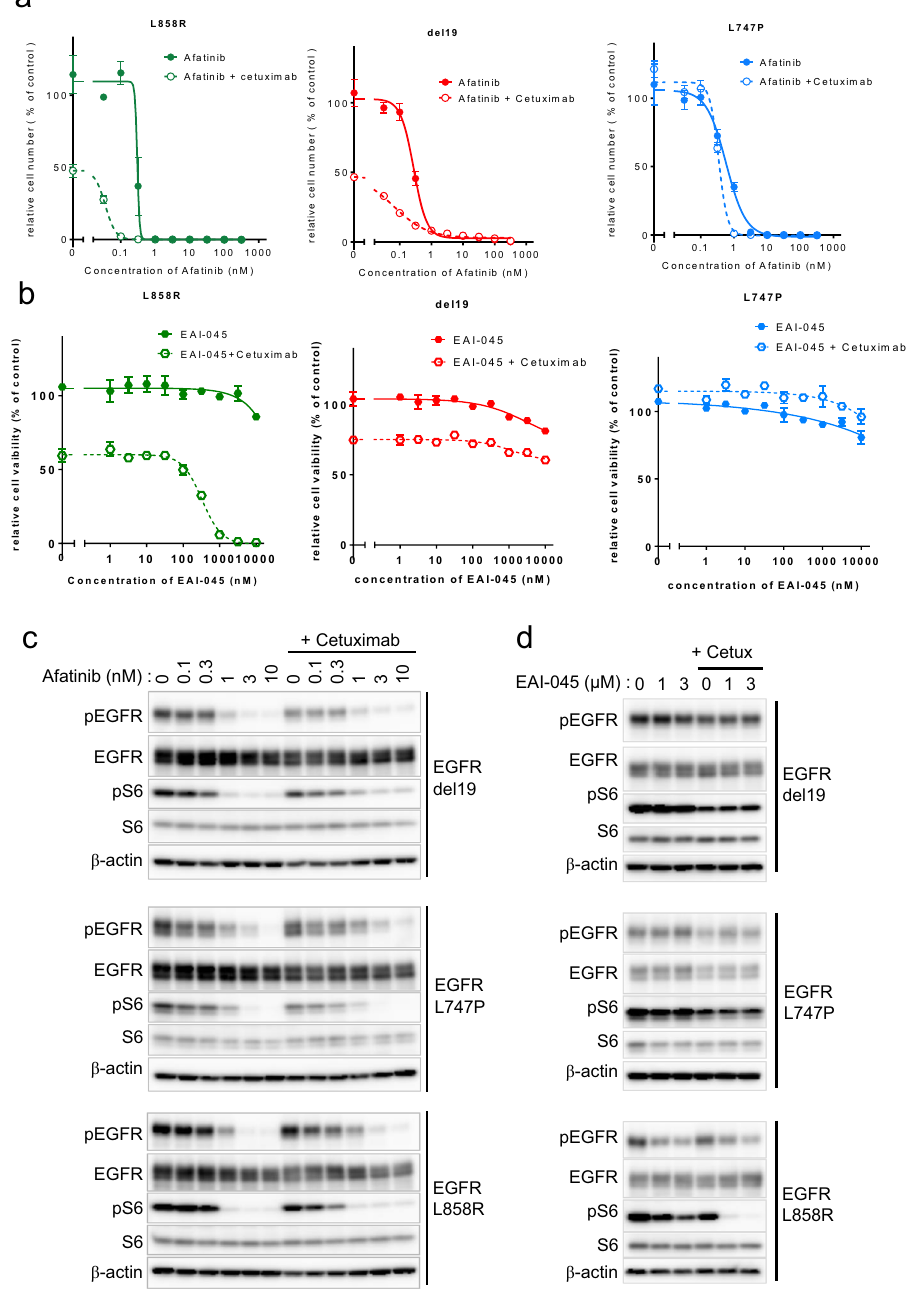
Fig. 4 Drug sensitivity pro fi le of the EGFR-L747P mutation using the anti-EGFR-antibody combination therapy. a Growth inhibition curve details. EGFR mutant Ba/F3 cells treated with combination therapy of afatinib and cetuximab. After 72 h of drug treatment, cell viability was measured using the CellTiter-Glo assay ( n = 3). b Growth inhibition curve details. EGFR mutant Ba/F3 cells treated with a combination therapy of EAI-045 and cetuximab. After 72 h of drug treatment, cell viability was measured using the CellTiter-Glo assay ( n = 3). c , d Inhibition of the EGFR signaling pathway in Ba/F3 EGFR mutant cells treated with the combination therapy of afatinib or EAI-045 with cetuximab (10 μ g/mL) for 3 h (for afatinib) or 6 h (for EAI-045) was evaluated by western blot with the indicated